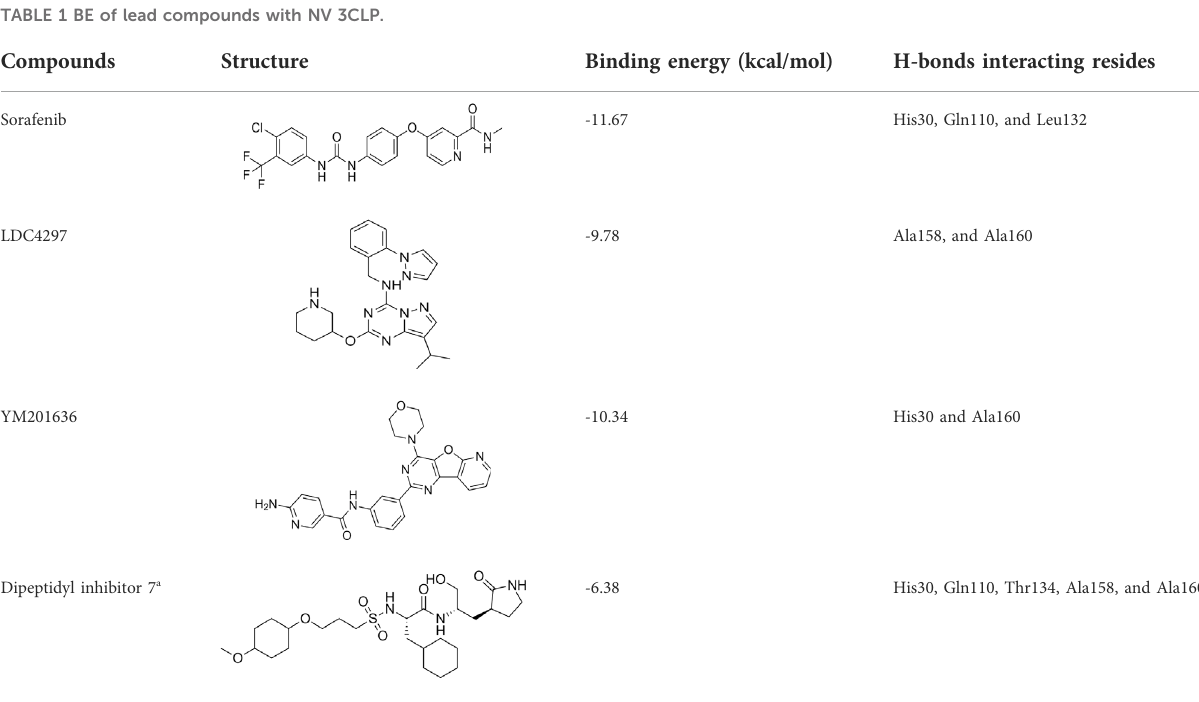
TABLE 1 BE of lead compounds with NV